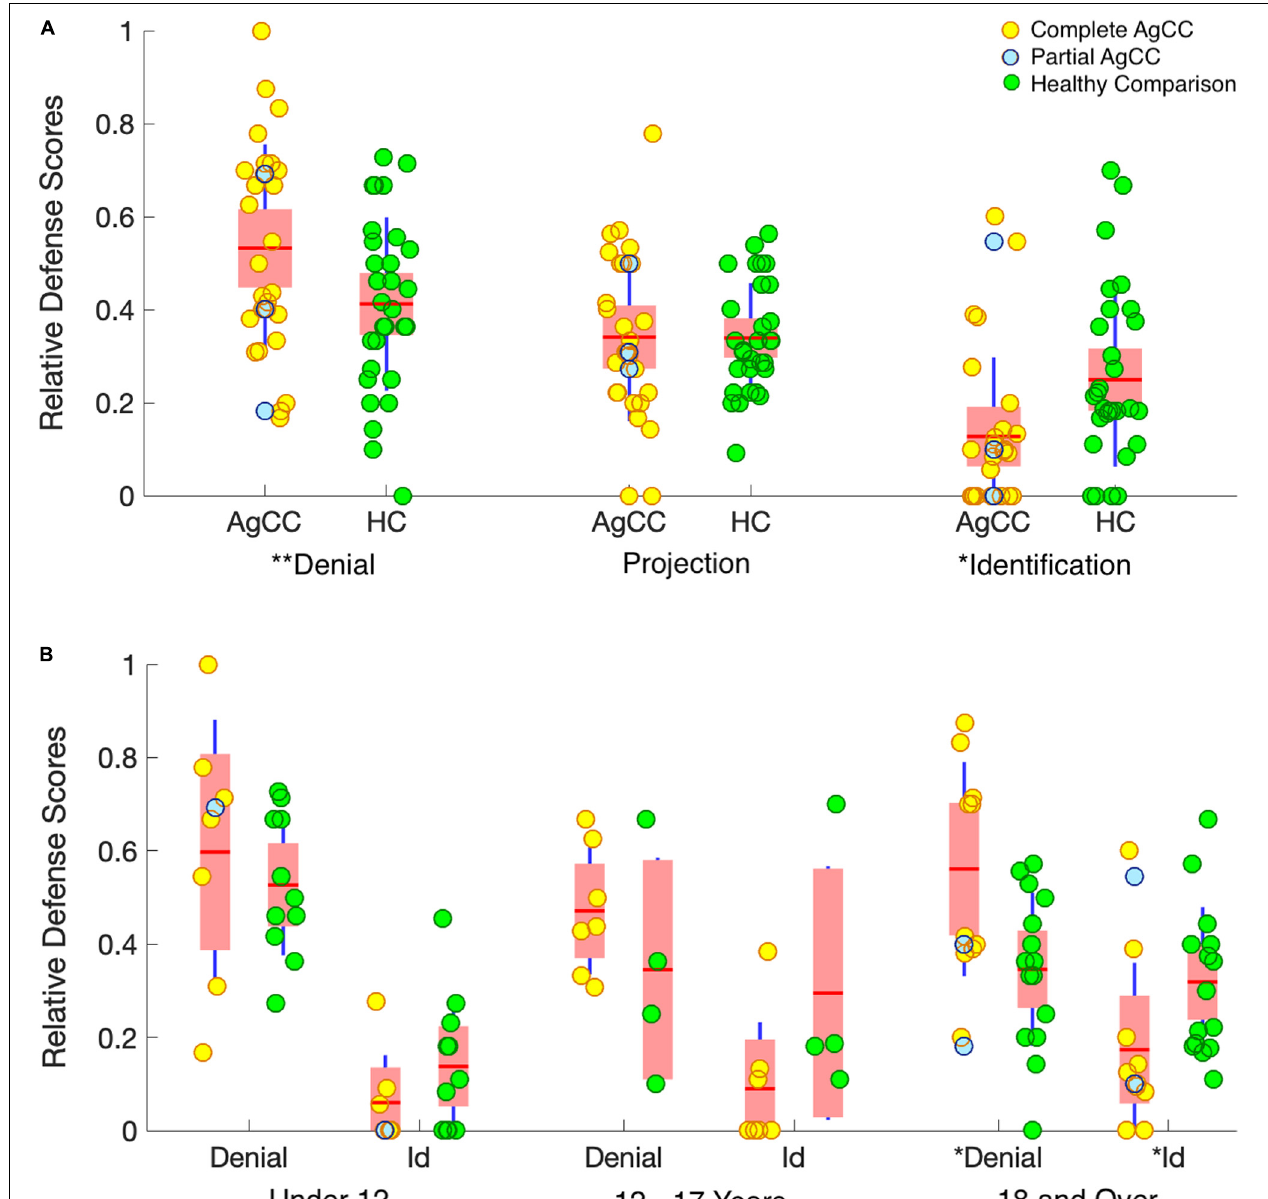
FIGURE 1 | Relative defense scores. (A) Results by group. (B) Results by group and age range (under 12, 12–17, 18, and over). Results from individual participants, complete AgCC (yellow circles), partial AgCC (blue circles), and healthy participants (green circles), are overlaid onto boxplots of group statistics. Group means are indicated by horizontal red lines. On each boxplot, the wider pink area represents standard error of the mean (95% confidence interval) and the additional dark-blue vertical lines indicate the standard deviation. * p < 0.05 and ** p <